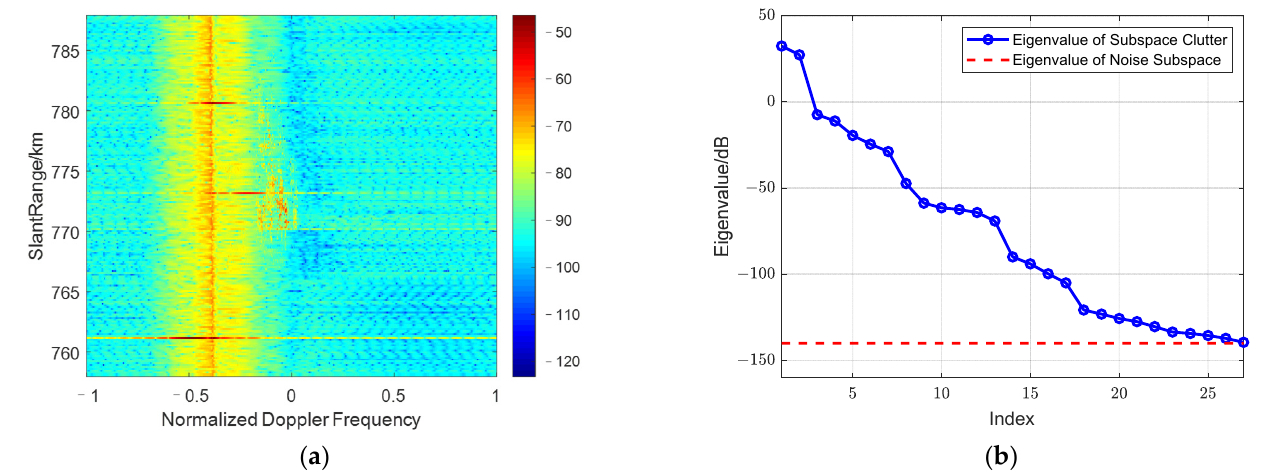
Figure 10. ( a ) The range-Doppler output power spectrum after using method 3.a; ( b ) The eigenvalue spectrum of the dimensionality reduction CCM.